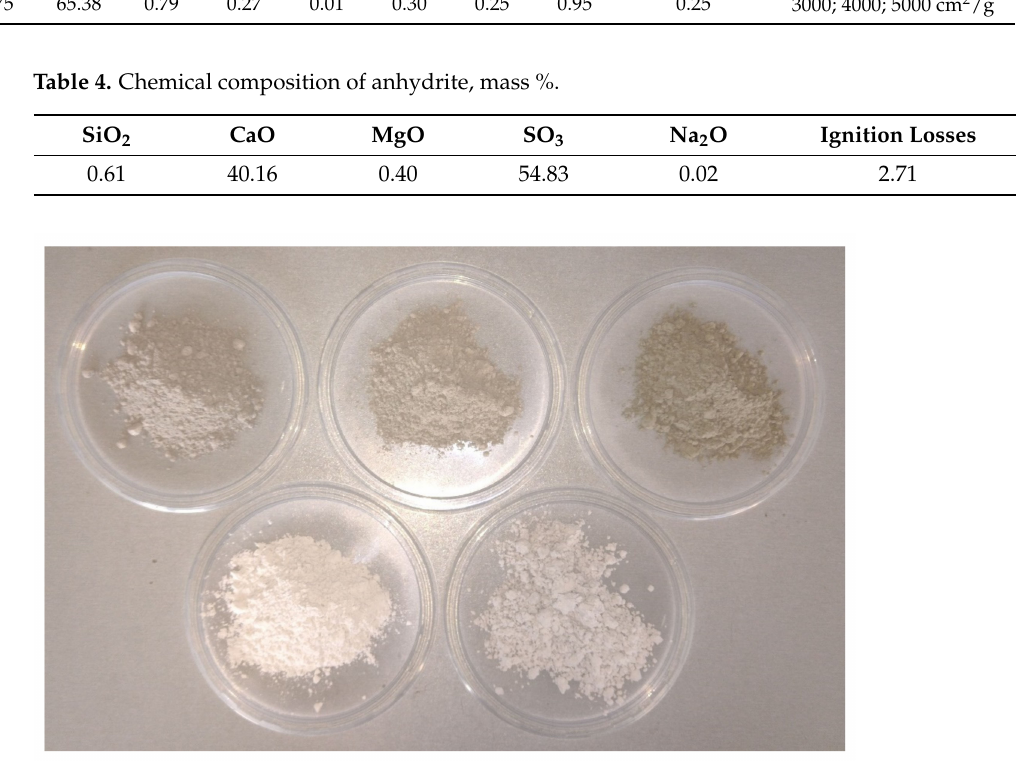
Figure 2. Clinkers (top row, from left C1, C2, C3), GGBFS (bottom row left), and anhydrite (bottom row right) involved in the